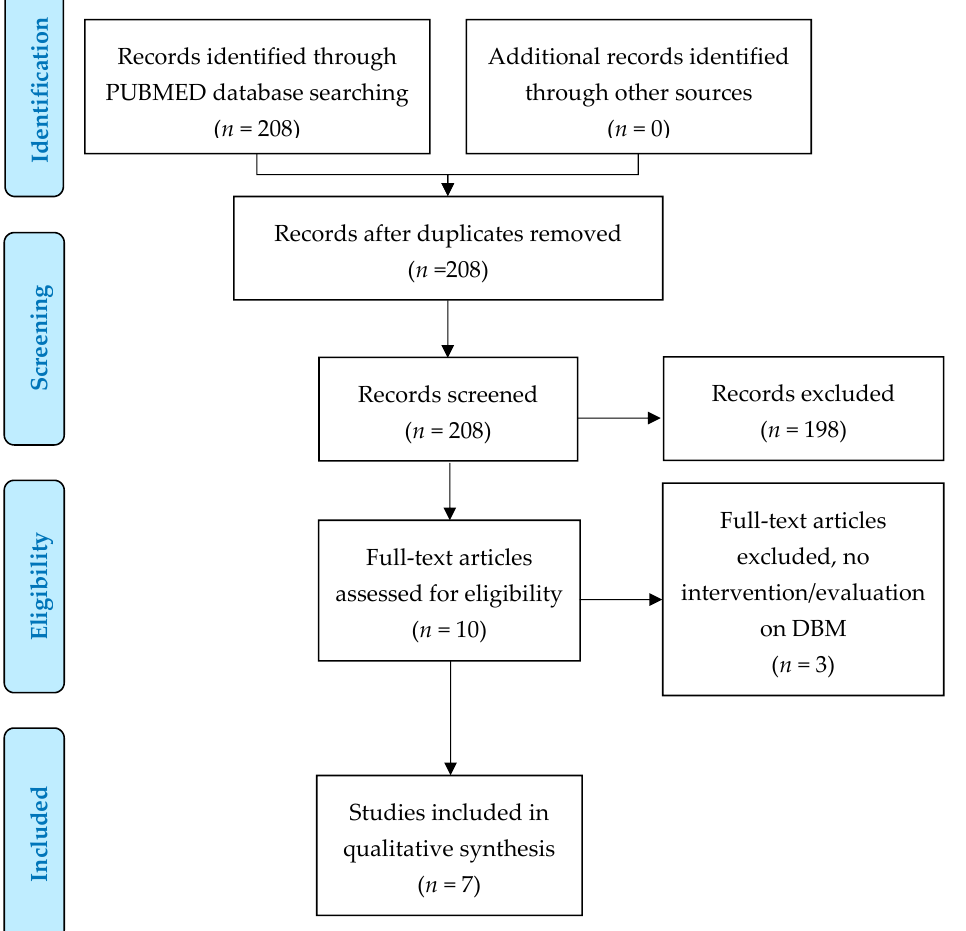
Figure 1. Preferred Reporting Items for Systematic Reviews and MetaAnalyses (PRISMA) flow diagram.